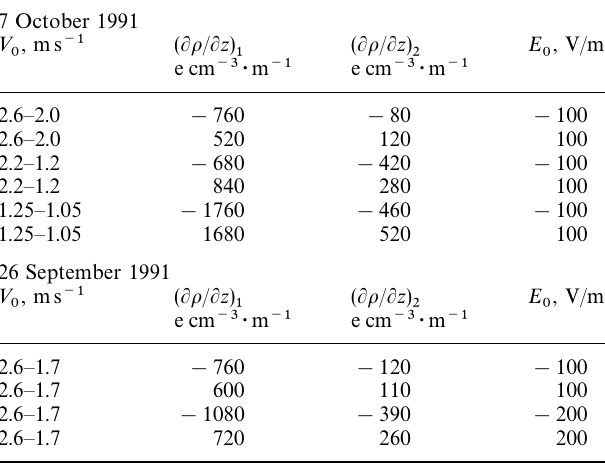
Table 1. The influence of the wind speed and external electric field on space-charge density